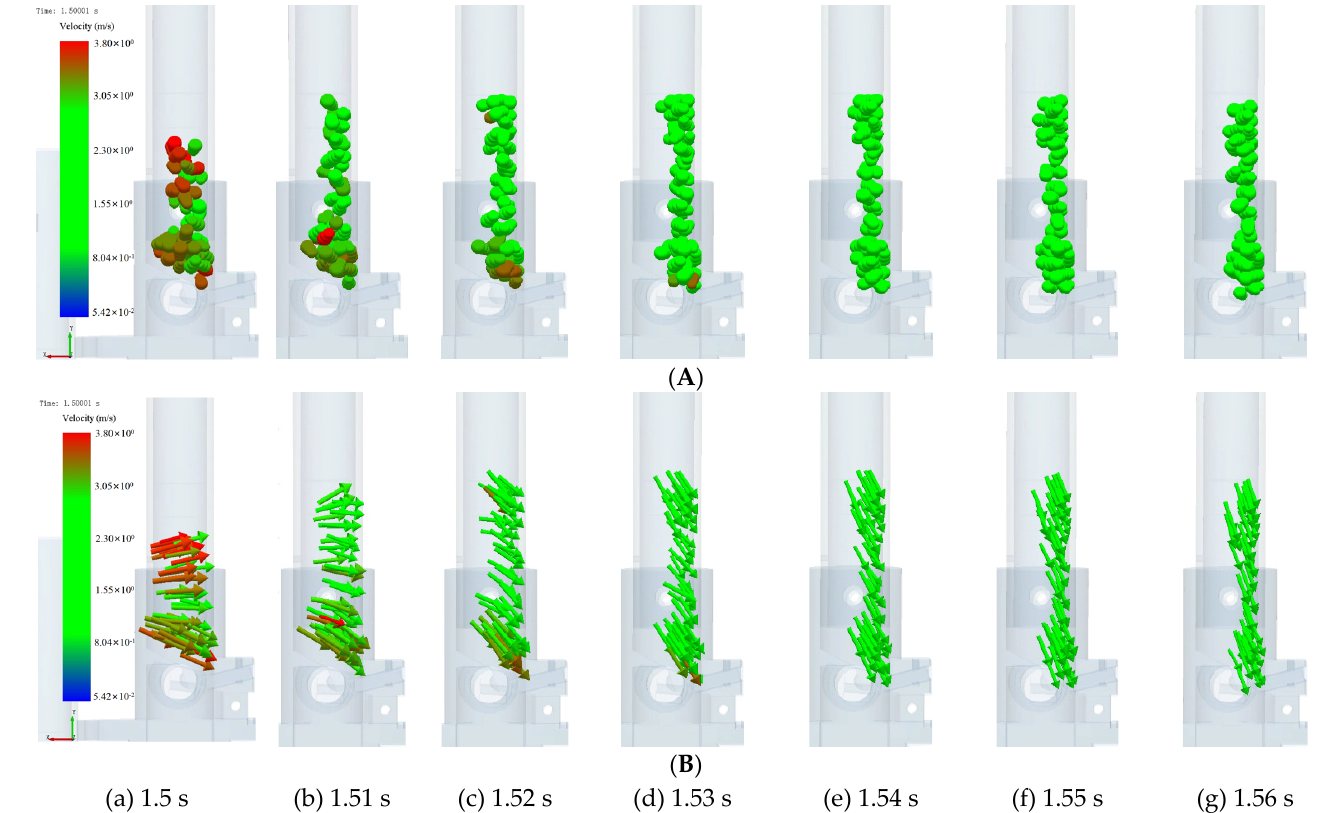
Figure 16. Movement process of horse tooth maize in traditional structural seed tube. ( A ) Default display. ( B ) Vector display.